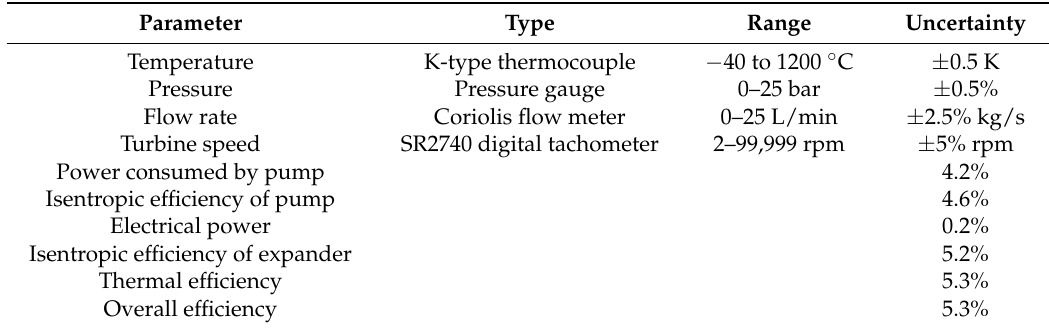
Table 5. Uncertainty measurement of the various parameters.